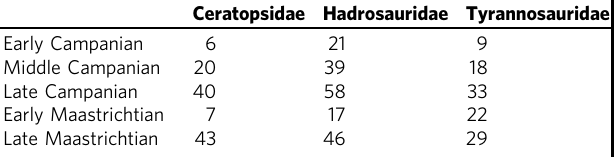
Table 1 Number of unique occurrences per time bin used as training sample for the ecological niche modelling Ceratopsidae Hadrosauridae Tyrannosauridae